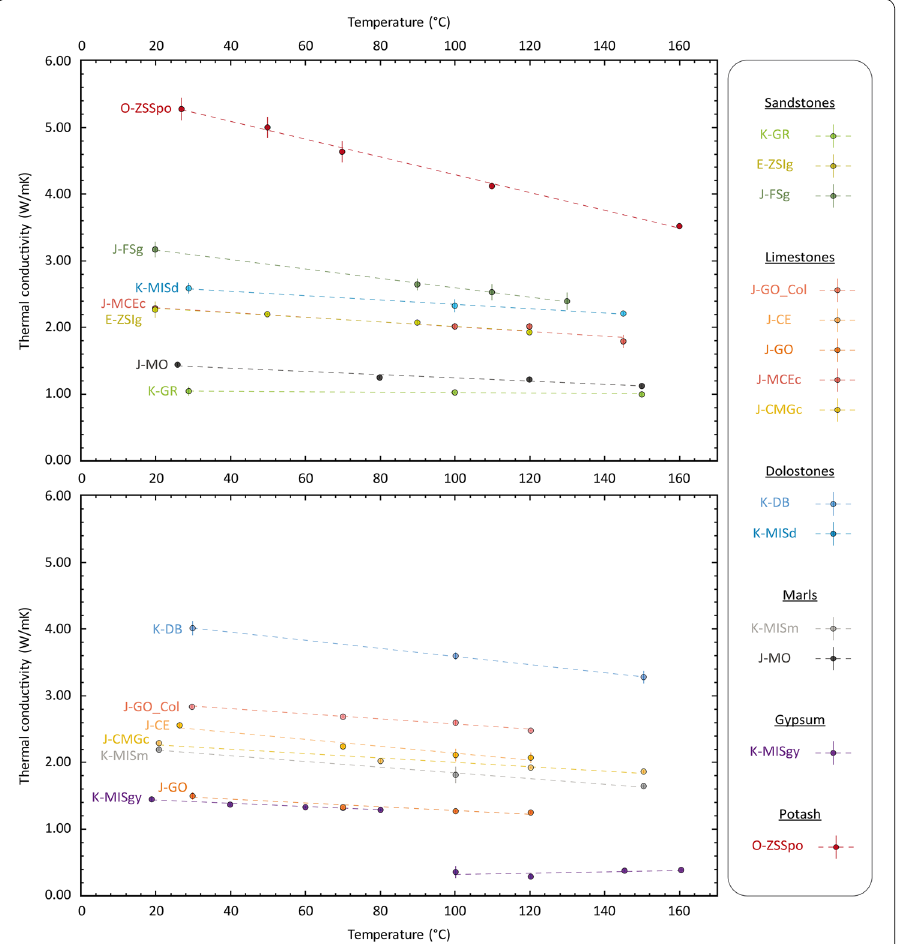
Fig. 8 Evolution of thermal conductivity of samples in the dry state as a function of temperature. Error bars indicate standard deviation of thermal conductivity. Colors correspond to lithologies. Names of the samples and trendlines (see Additional file 2 for equations) are indicated. The data are represented in two separate graphs for